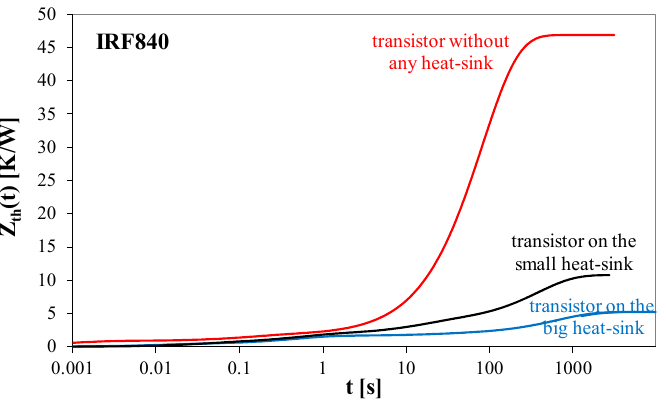
Figure 8. Waveforms of transient thermal impedance of the IRF840 transistor operating at different cooling conditions.